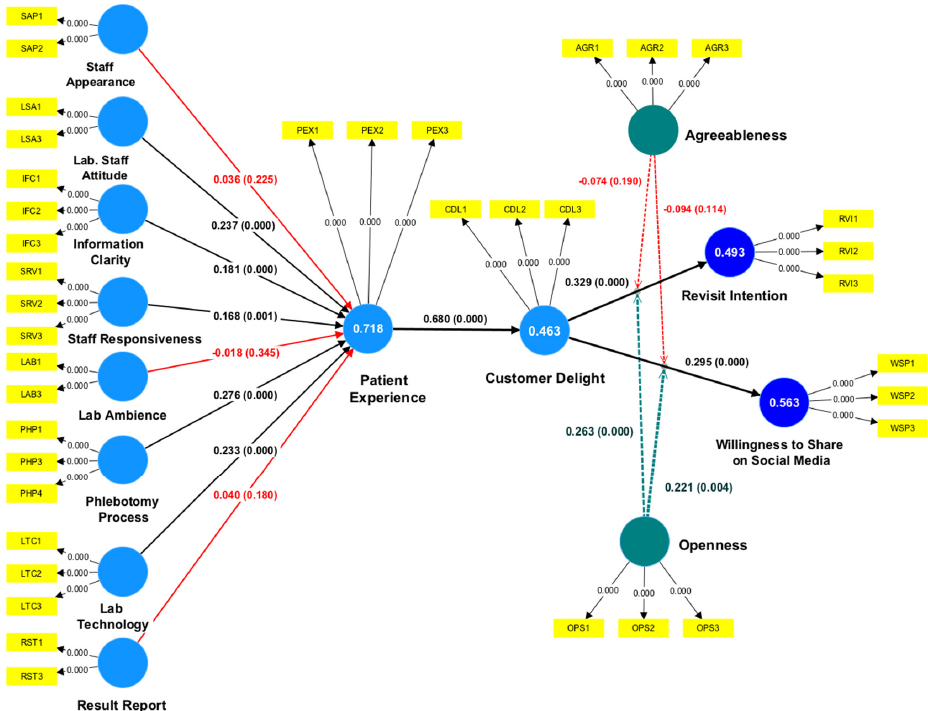
Figure 4. Result model.